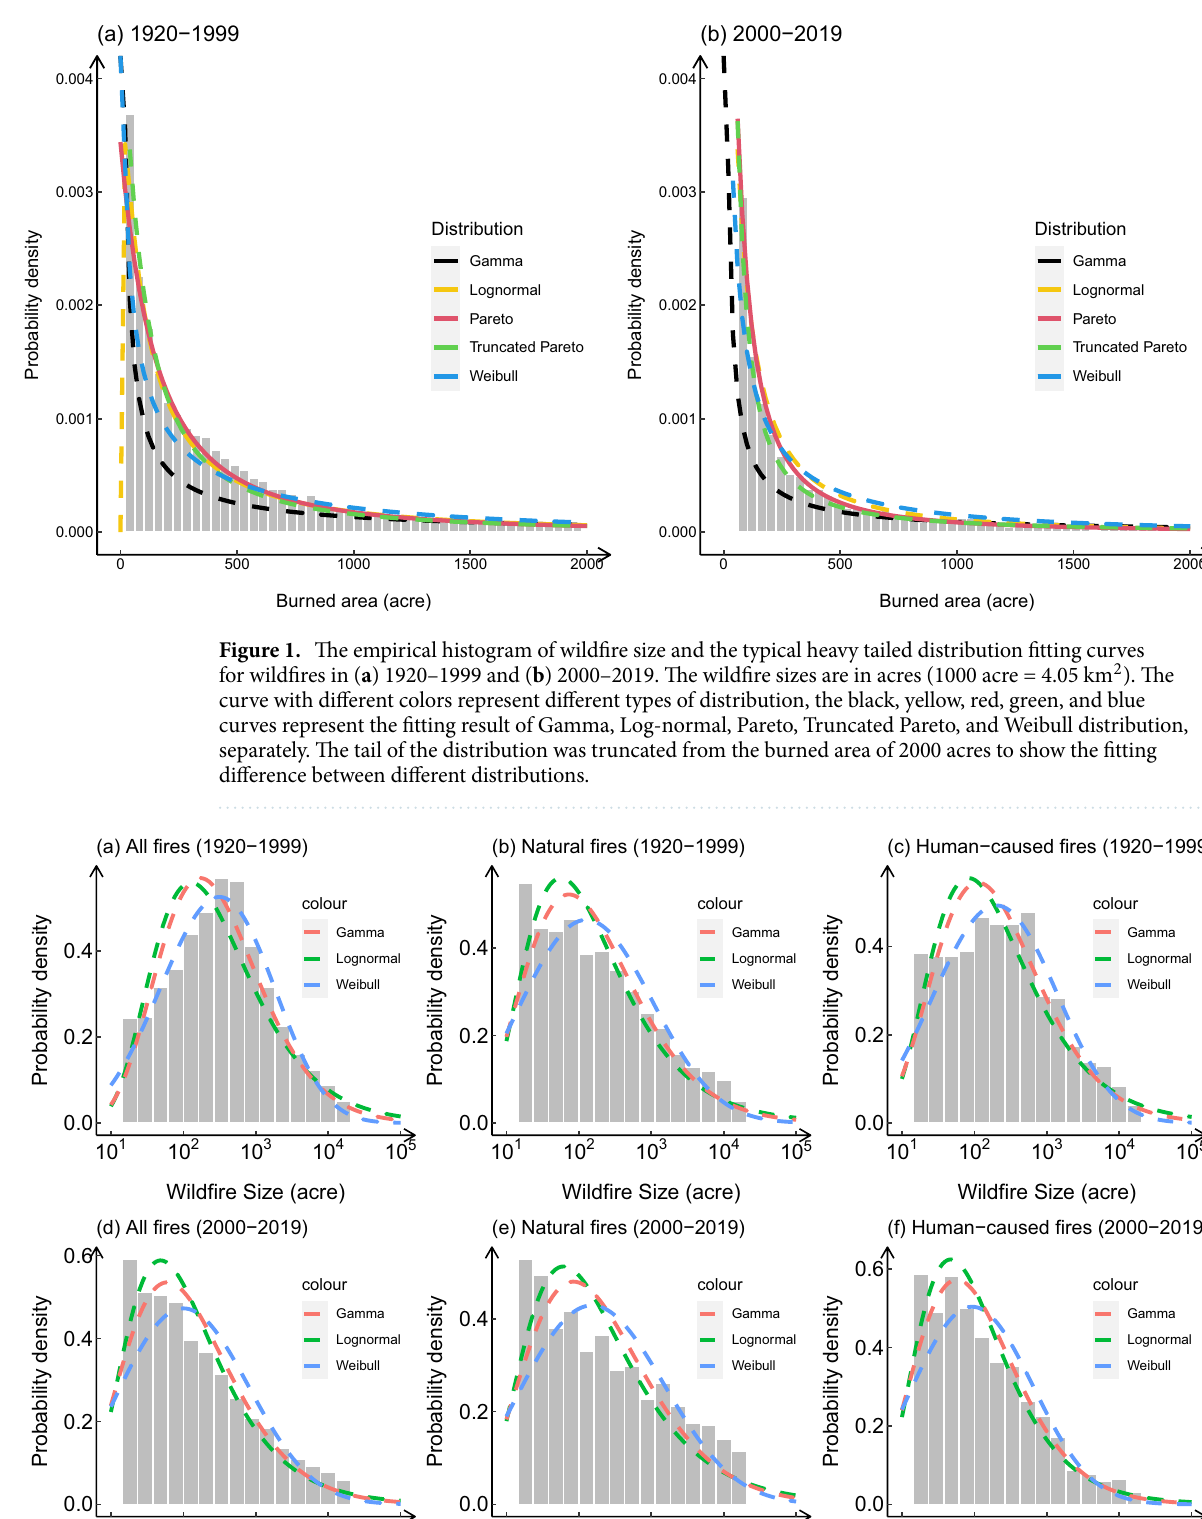
Figure 2. Logarithm of California wildfire size empirical distribution in 1920–1999 and 2000–2019. The Gamma, Lognormal and Weibull distribution fitting results are indicated by the red, green and blue dash lines. 2 The wildfire sizes are in acres (1000 acre = 4.05 km ). ( a – c ) are the historical wildfires from 1920 to 1999, ( d – f ) are the wildfires from 2000 to 2019; ( a , d ) are the distribution of all wildfires, ( b , e ) are the distribution of natural wildfires, ( c , f ) are the distribution of human-caused